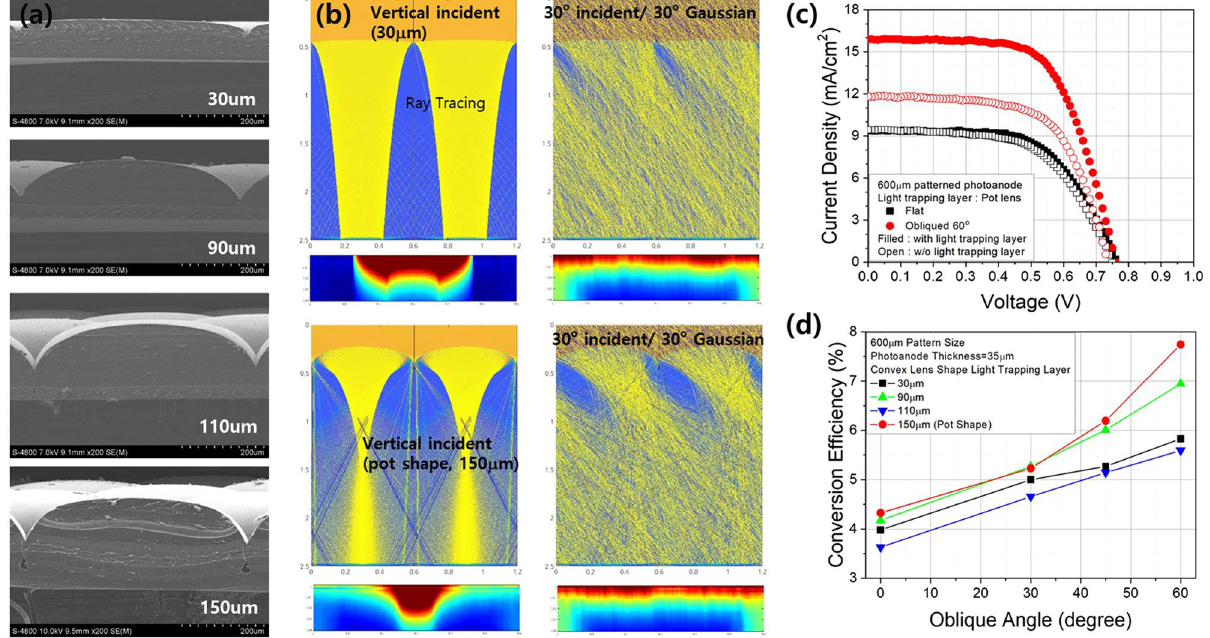
Figure 6. ( a ) Scanning electron microscopy (SEM) images of the dependence of the performance of the lens array light-trapping layer on the height of the lens. ( b ) Light distribution and intensity within the patterned photoanode using lenses of heights 30 µ m (up) and 150 µ m (down) incident vertically (left) on the cell and with each photon having a Gaussian angle of incidence with the Gaussian distribution centered at 30 degrees and with a range of 30 degrees (right). ( c ) Relationship between the current density and voltage of 600 µ m patterned photoanode DSSCs with or without a pot-shaped lens array-based light-trapping layer in cases of vertically or 60° obliquely angled incident light under 1 sun AM1.5 conditions. ( d ) Dependence of the conversion efficiency of such DSSCs with lens array-bases layers on the height of lenses in cases of vertically and 30°, 45°, and 60° obliquely angled incident light under 1 sun AM1.5